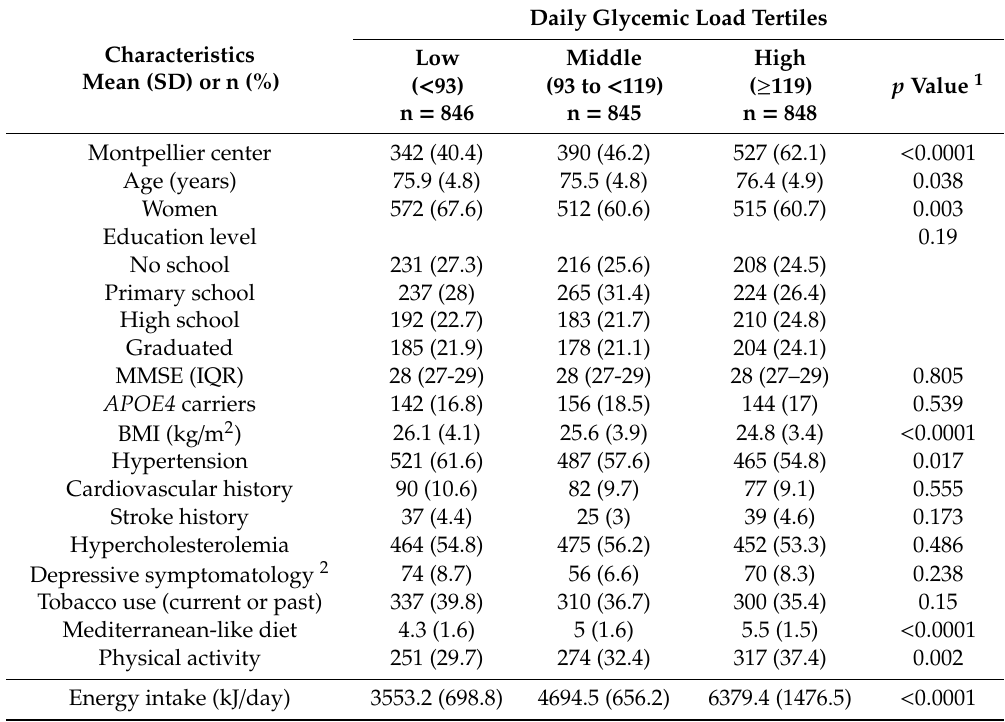
Table 1. Description of the study population (n =